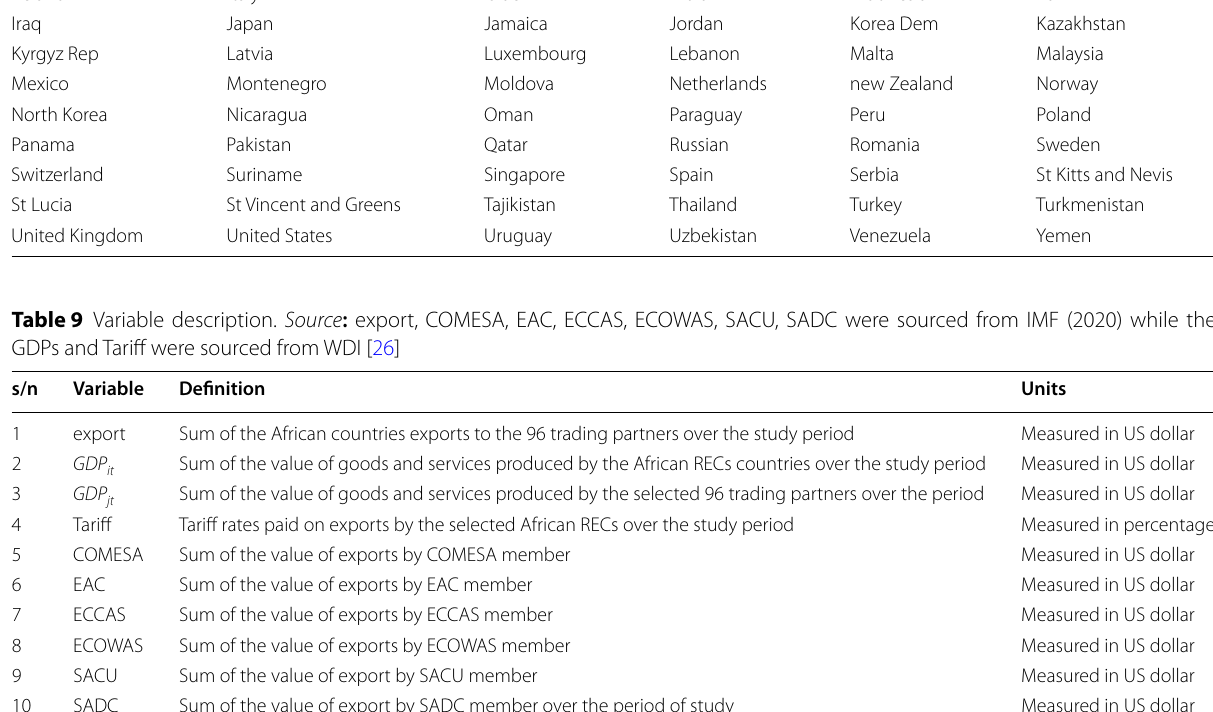
Table 10 Residual Stationarity